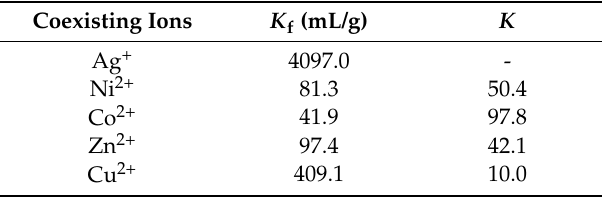
Table 6. The values of K f and K of coexisting ions.